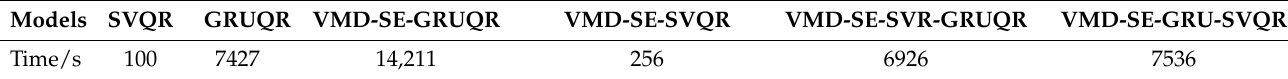
Table 7. Training time of six